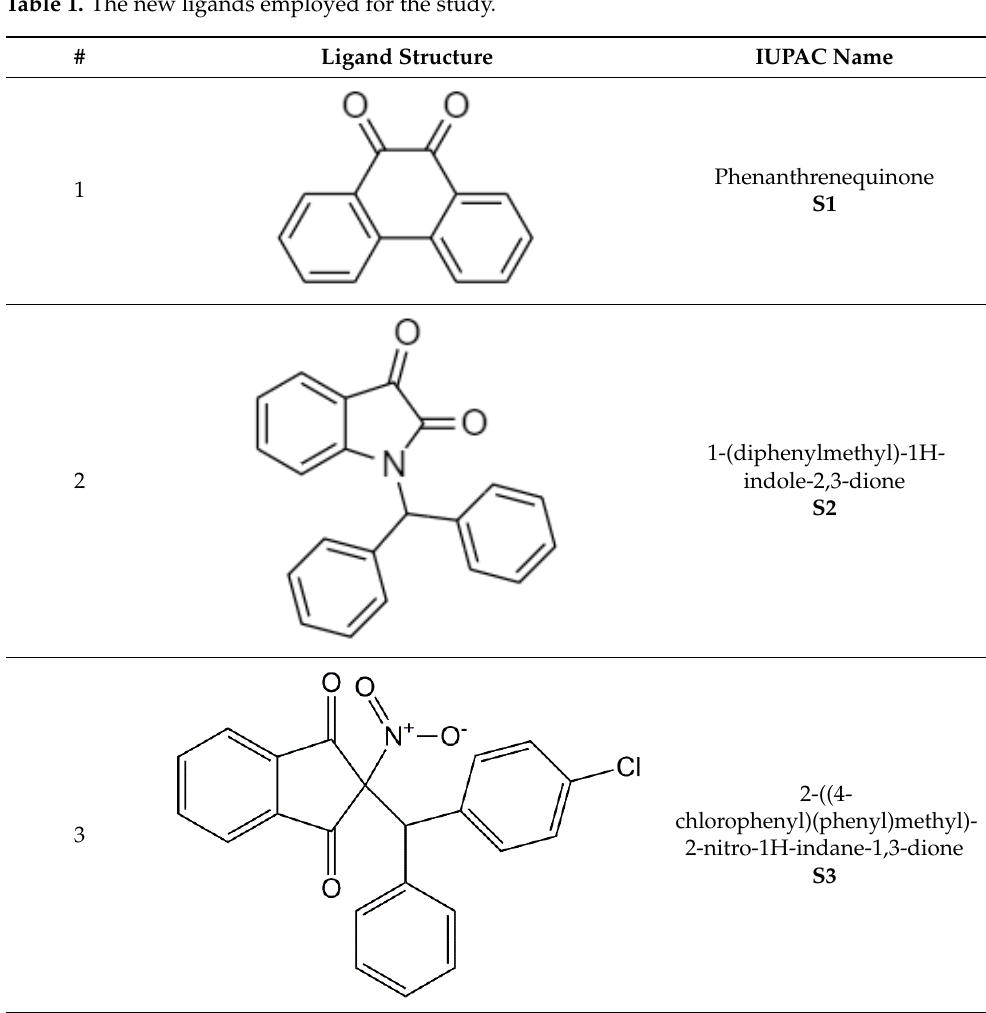
Table 1. The new ligands employed for the study.